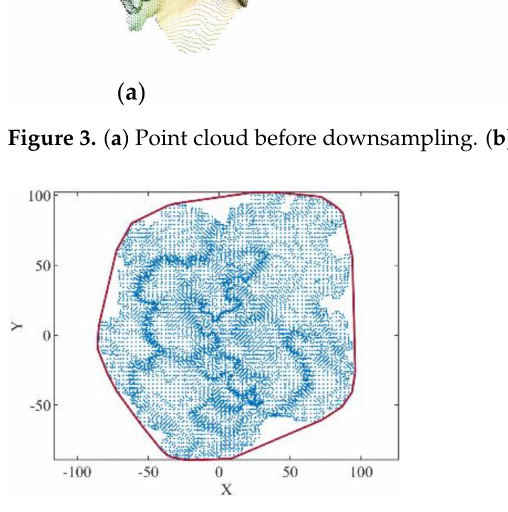
Figure 4. The result of convex hull algorithms in rapid.